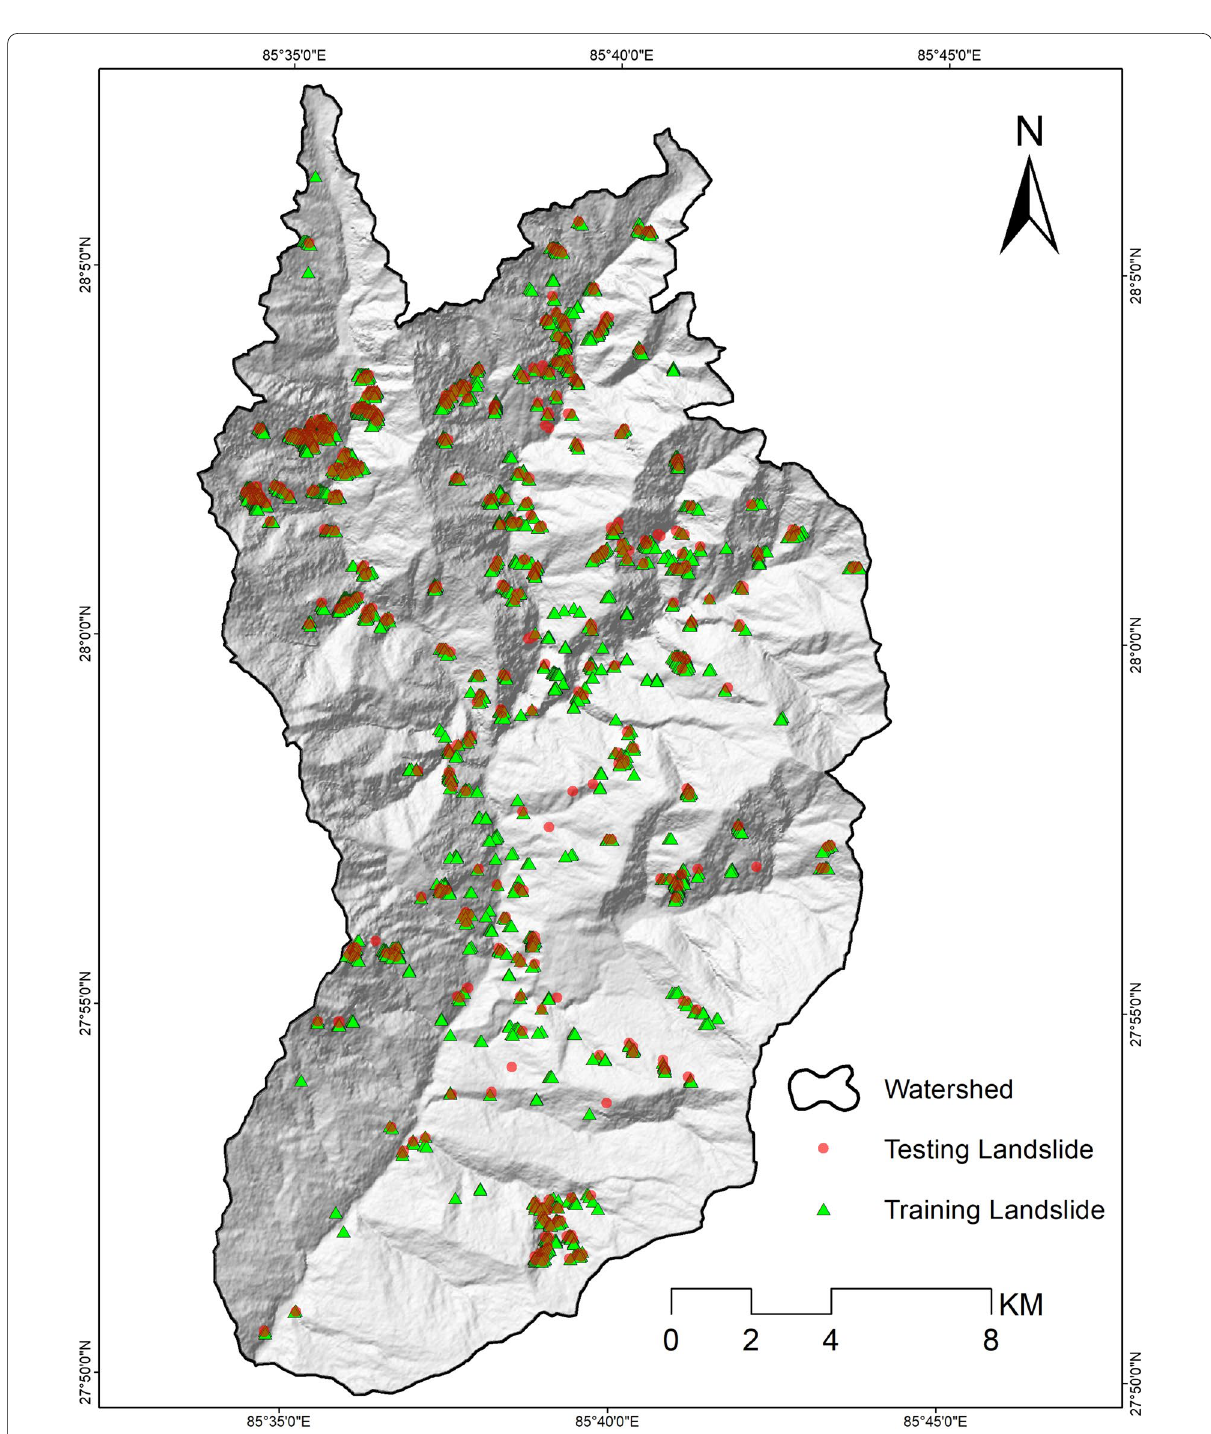
Fig. 3 Distribution of training landslides and validation